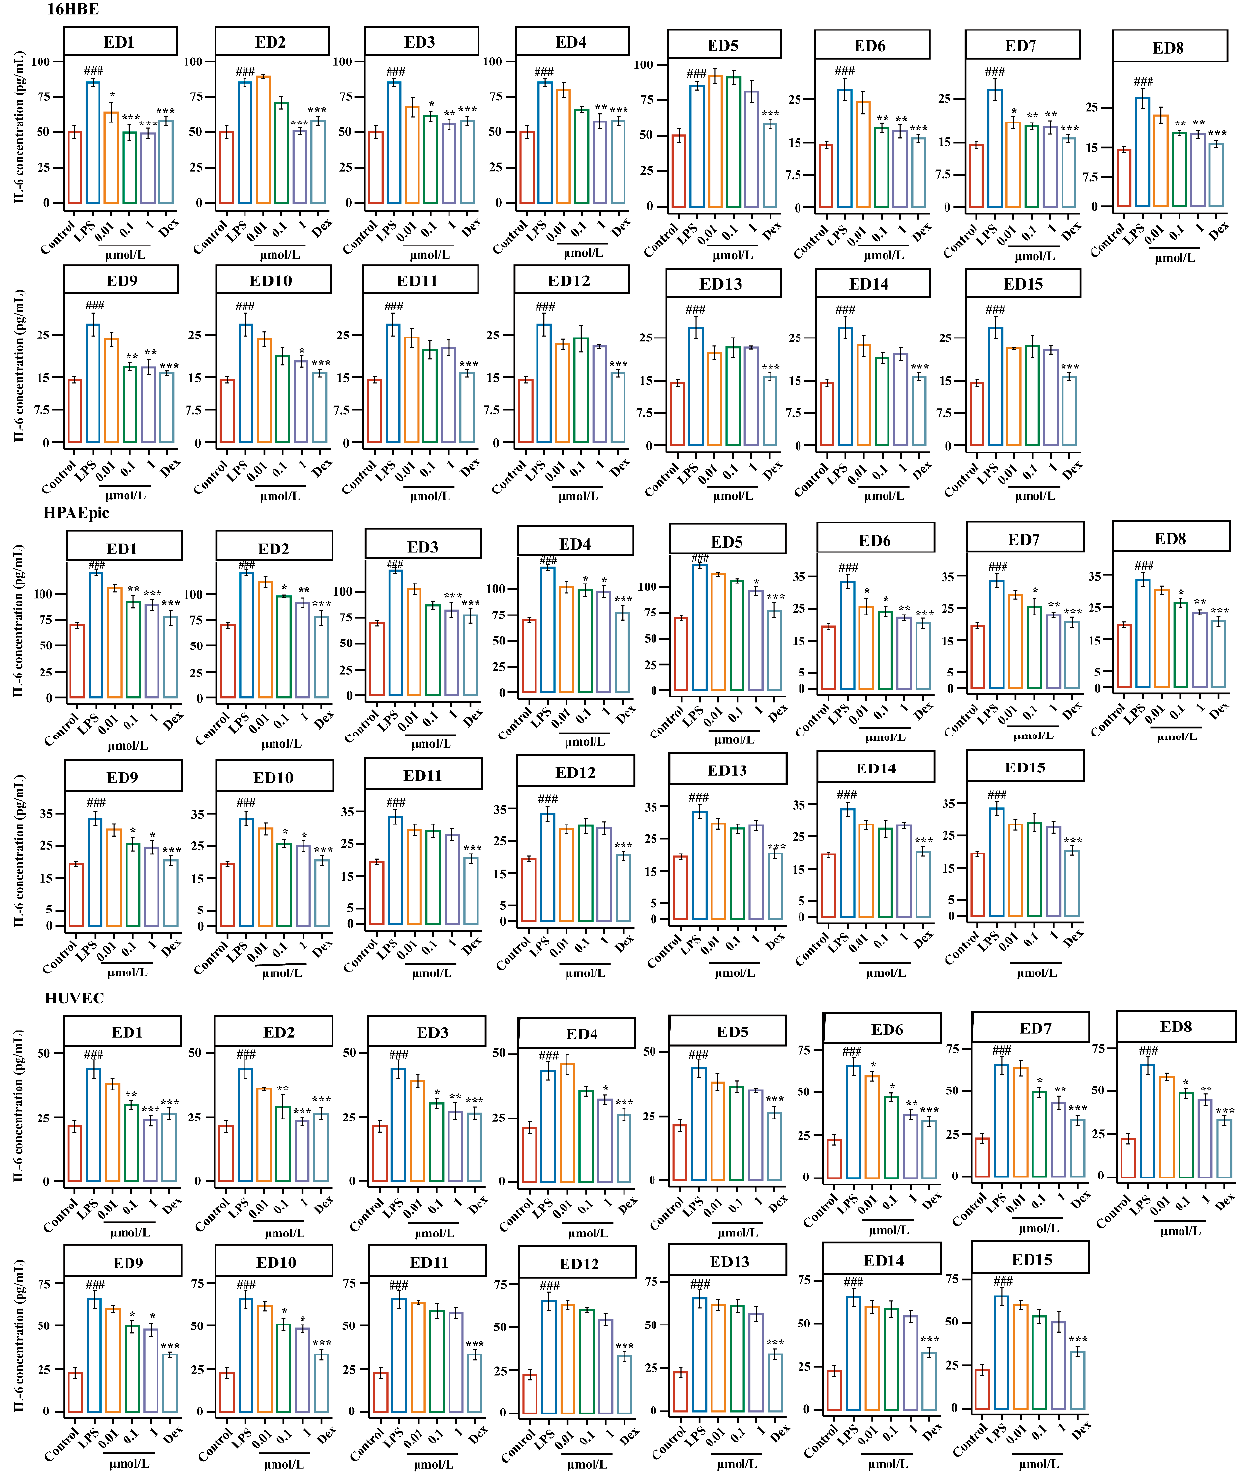
Figure 6. Effects of ED1 ‐ DE15 on IL ‐ 6 levels in LPS ‐ induced cell injury in target cells. The 16HBE, HPAEpiCs and HUVECs were pretreated with ED1 ‐ 15 at the concentration of 0.01 ‐ 1 μ M for 12 h. Dex was used as a positive control drug (5 μ g/mL). IL ‐ 6 levels in the medium, as measured by ELISA. Results were obtained from three independent experiments and are presented as mean ± SEM. ### p < 0.001 vs. Control; * p < 0.05, ** p < 0.01, *** p < 0.001 vs. LPS. LPS, Lipopolysaccharide; Dex, Dexamethasone.